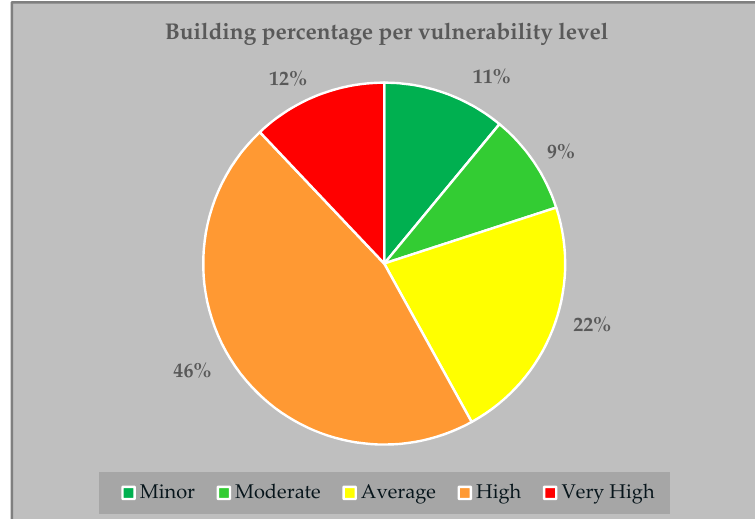
Figure 11. Relative Vulnerability Index (RVI) percentage per vulnerability level.